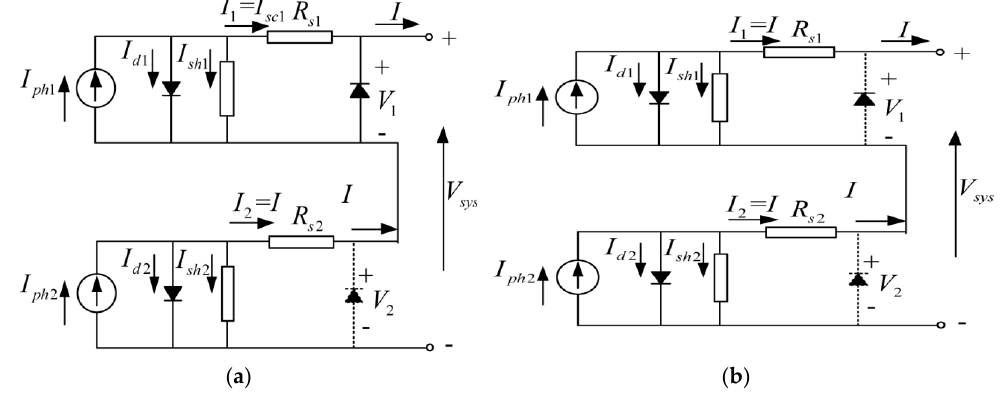
Figure 2. Array of 2 PV array connected in series; ( a ) I > I sc 1 and ( b ) I < I sc 1